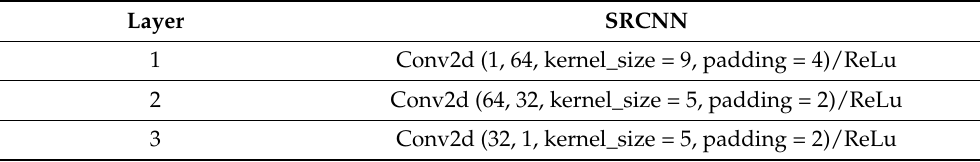
Table 4. SRCNN architecture.